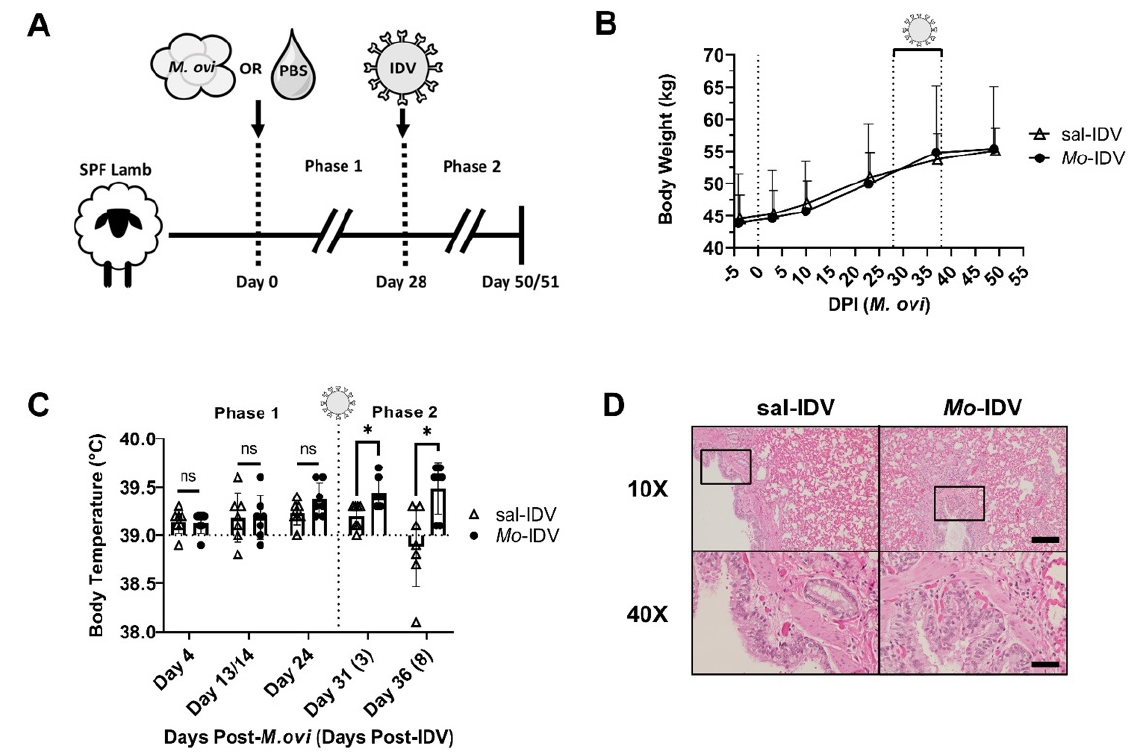
Figure 1. IDV with or without recent M. ovipneumoniae infection does not induce clinical symptoms in SPF lambs. ( A ) Schematic representation of experimental design. On day 0, seven lambs were administered M. ovipneumoniae (3.5 × 10 8 CFU) or PBS control ( n = 7 lambs/group); at day 28, all lambs were inoculated with IDV (D/Oklahoma/1337/2011; 1.86 × 10 5 PFU). ( B ) Weights and ( C ) rectal temperatures were monitored throughout the study. ( D ) Representative histological analysis of distal lungs from each treatment group. Boxes on 10 × images denote 40 × field. 10 × scale bar: 500 µ m; 40 × scale bar: 100 µ m; M. ovi : M. ovipneumoniae ; comparisons evaluated by Student’s t -test; * Bonferroni–Dunn-adjusted p < 0.05, ns: p > 0.05. Vertical dashed lines denote IDV shedding period ( B ) or inoculation ( C ), horizontal line indicates average clinically normal lamb rectal temperature (39 ◦ C). Data are represented as mean ± standard deviation